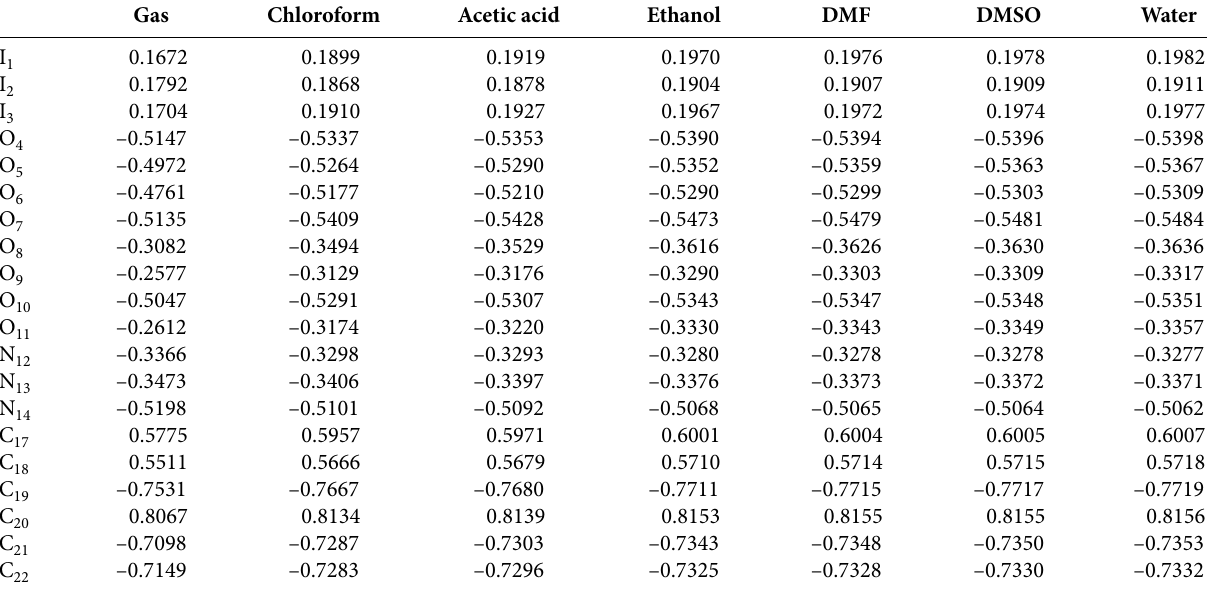
Table 6. Some Mulliken Atomic charges (e) of Iopamidol in various solvents.